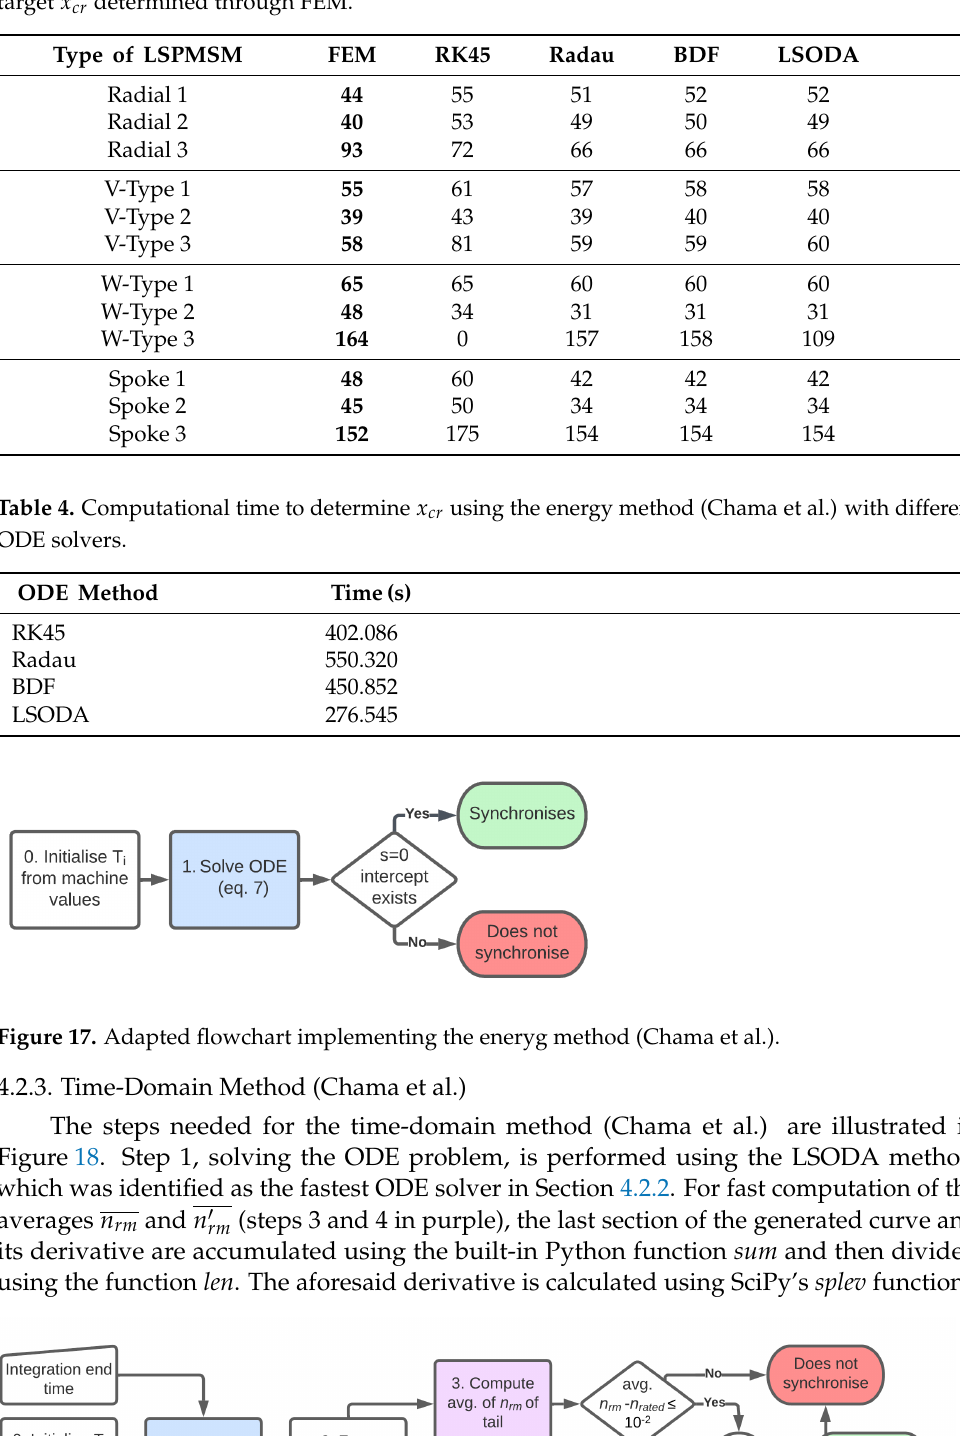
Table 3. x cr determined by the energy method (Chama et al.) with various ODE solvers compared to target x cr determined through FEM.